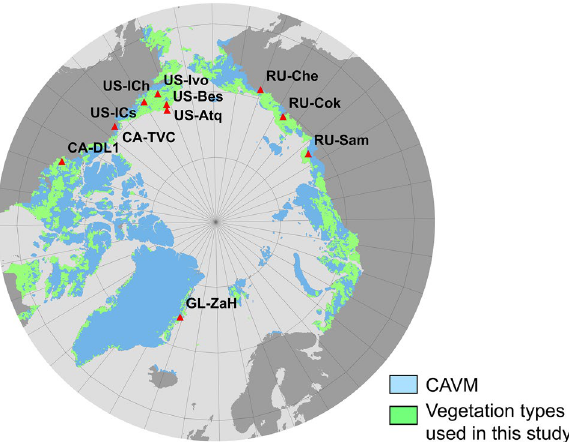
Figure 1. Study sites. Locations of the 11 eddy covariance flux tower sites used in this study. Light blue regions delineate the total Circumpolar Arctic Vegetation Map (CAVM), green regions delineate the subset of CAVM vegetation types represented in this study (including all the vegetation types listed in Table S1). This map was created using QGIS.org, 2020, QGIS 3.10. Geographic Information System User Guide. QGIS Association: https:// docs. qgis. org/3. 10/ en/ docs/ user_ manual/ index. html. The dataset used in the map was the CAVM map: CAVM Team. 2003. Circumpolar Arctic Vegetation Map. (1:7,500,000 scale), Conservation of Arctic Flora and Fauna (CAFF) Map No. 1. U.S. Fish and Wildlife Service, Anchorage, Alaska. ISBN: 0-9767525-0-6, ISBN-13: